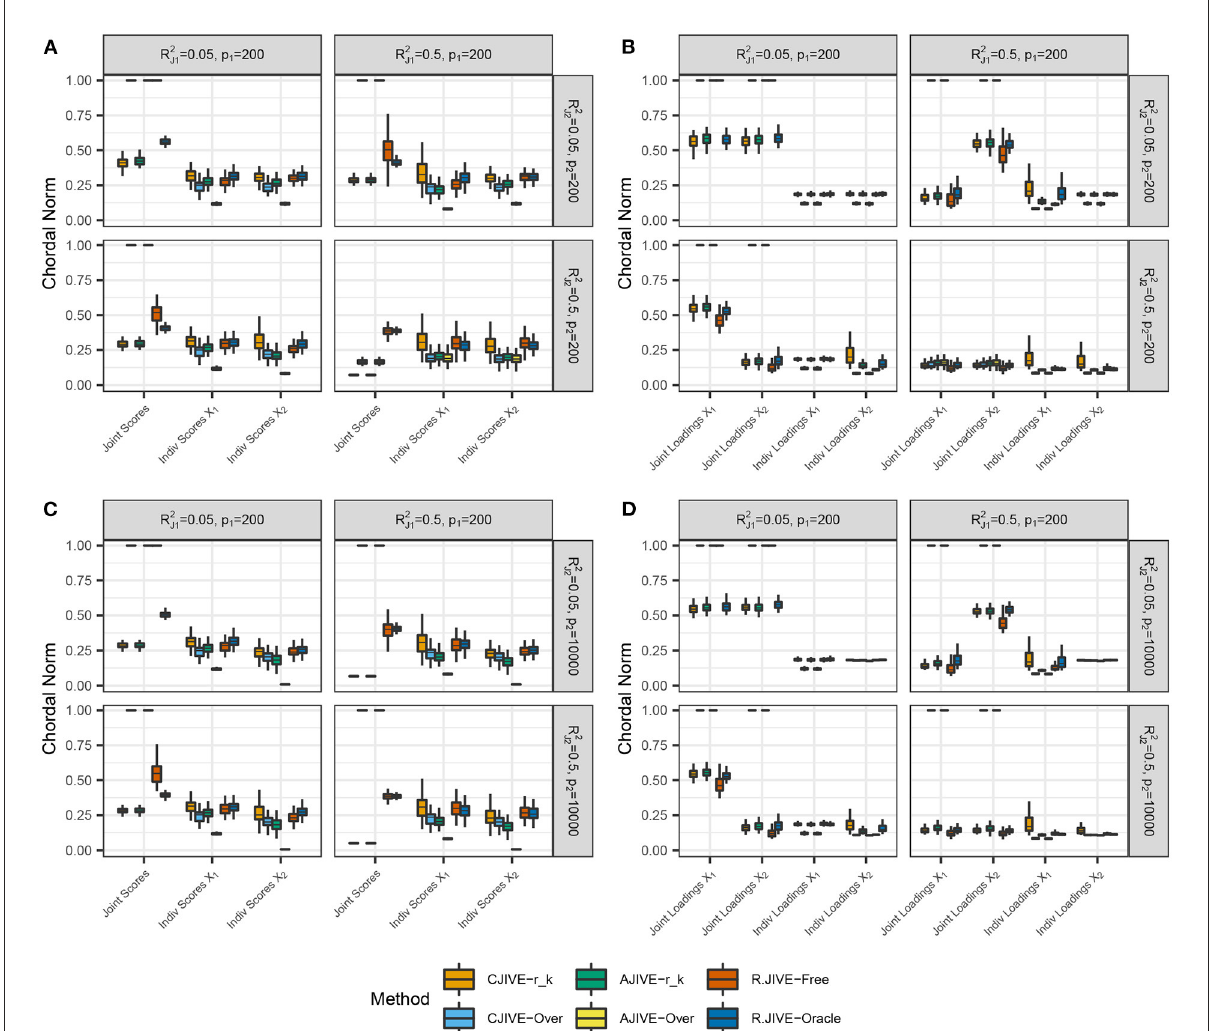
FIGURE3 Results of simulation studies: (A,B) p 2 200, (C,D) p 2 10,000. Each sub-figure exhibits boxplots of chordal norms for each of the post-JIVE = = measurements described in Section 2.1. Methods with chordal norms equal to 1 result when the estimated joint rank is 0 for all replicates. R 2 J 1 and R 2 J 2 represent the true joint variation controlled in simulations. We held the sample size, joint rank, and proportions of individual variation R 2 I 2 explained constant at n 200, r J 3, and R 2 I 1 0.25, respectively. The left column (A,C) , show chordal norms between true and estimated = = = = subject scores. The right column (B,D) , show chordal norms between true and estimated variable loadings.